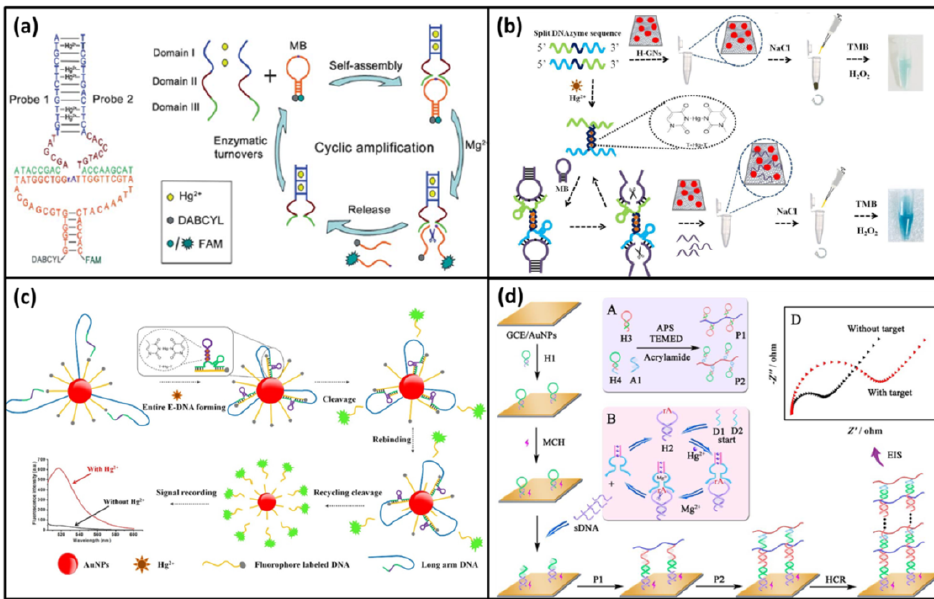
Figure 11. ( a ) The scheme of a fluorescence DNA biosensor to detect Hg 2+ based on splitting Mg 2+ - dependent DNAzyme. Reprinted with permission from [86]. Copyright 2012 Royal Society of Chemistry. ( b ) The scheme of a visual and sensitive DNA biosensor for Hg 2+ detection based on split DNAzyme amplification and peroxidase-like activity of hemin-graphene composites (H-GNs). Reprinted with permission from [92]. Copyright 2019 Elsevier. ( c ) The scheme of a simple and amplified Hg 2+ detection strategy based on DNAzyme motor. Reprinted with permission from [93]. Copyright 2018 Elsevier. ( d ) The scheme of an electrochemical impedance biosensor for Hg 2+ detection based on DNAzyme-assisted target recycling and hybridization chain reaction (HCR). Reprinted with permission from [94]. Copyright 2017